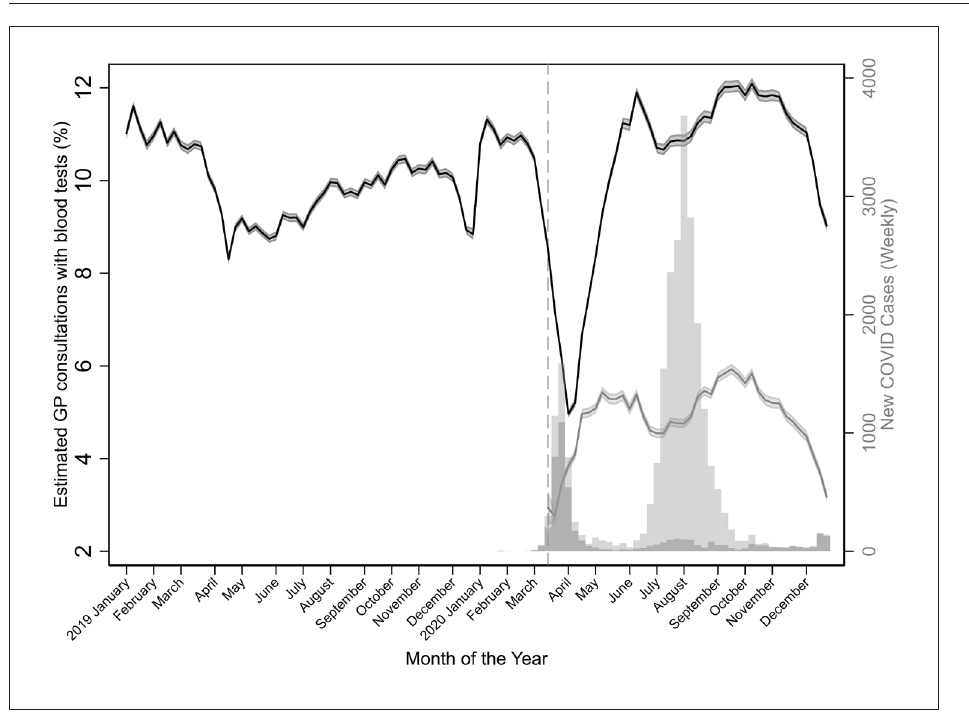
Figure 2 Estimated proportion (and 95% confidence intervals) of face- to- face (black) and telehealth (grey) GP consultations with blood tests from January 2019–December 2020. Dashed vertical line indicates the time at